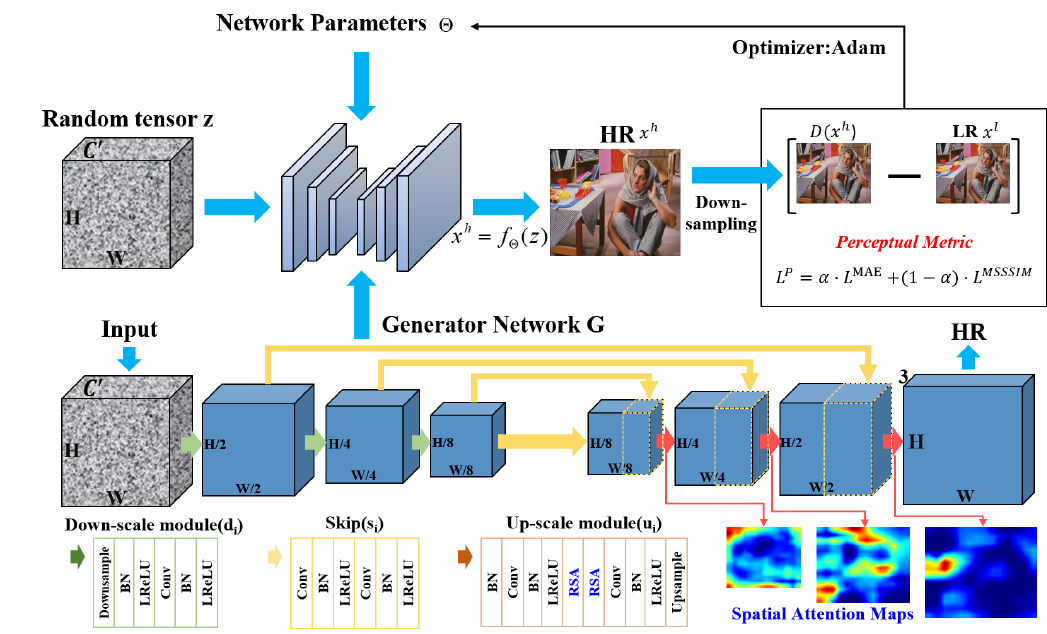
Figure 1. The flowchart of the proposed perceptual metric guided deep attention network (PM-DAN) for single image super-resolution